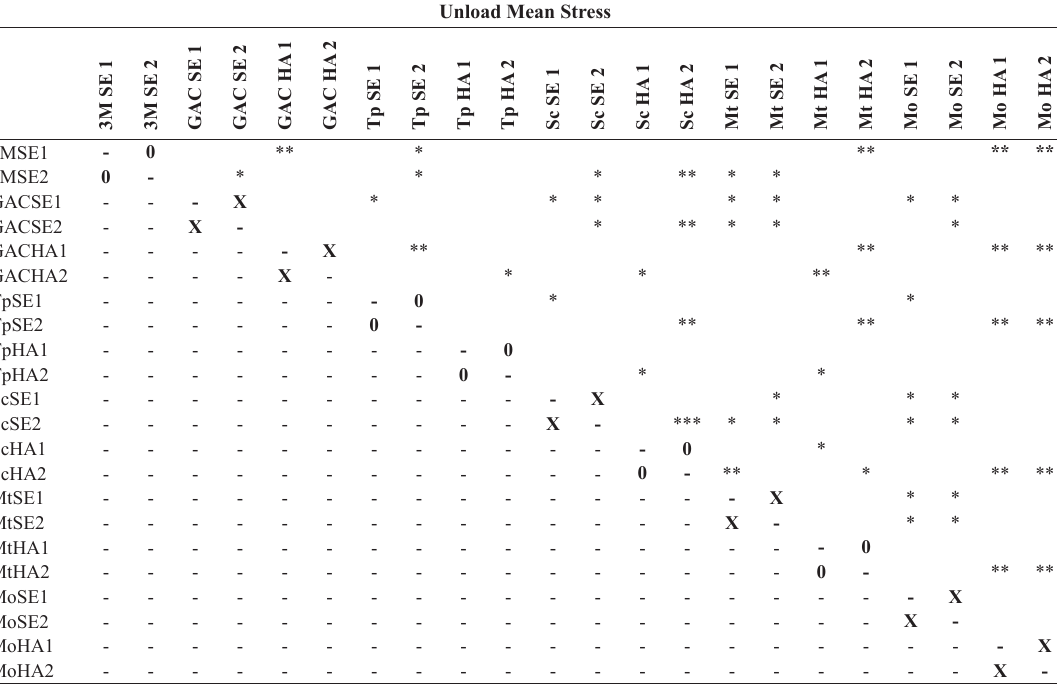
Table 5. Unload mean stress comparison among different groups and commercial lots by Tukey test (p=0.05).